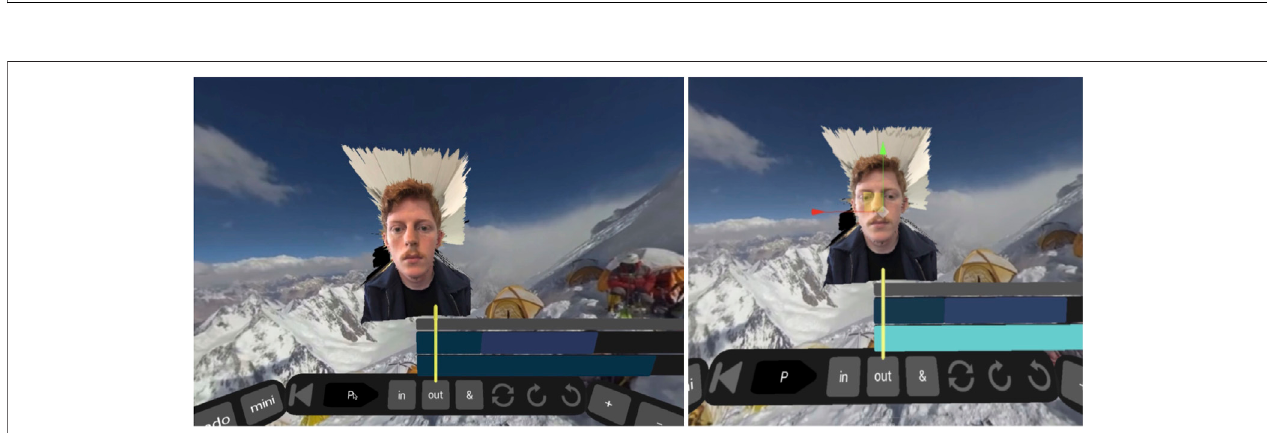
FIGURE 7 | Temporal editing vs. spatial editing. The left fi gure shows temporal editing: Using the timeline to align two VR video clips embedded in a multilayer timeline.Theright fi gureshowsthemanipulationinterfaceforcompositingoftwoVRvideoclips.TheinterfaceallowstheeditortomoveoneVRvideoclipinvirtualspace. Please note that the artifacts visible around the person are due to depth map inaccuracies and not a problem speci fi c to the immersive video editor. In this example the video clip with the person is captured using a mobile phone, in such cases, the artifacts can become more noticeable.